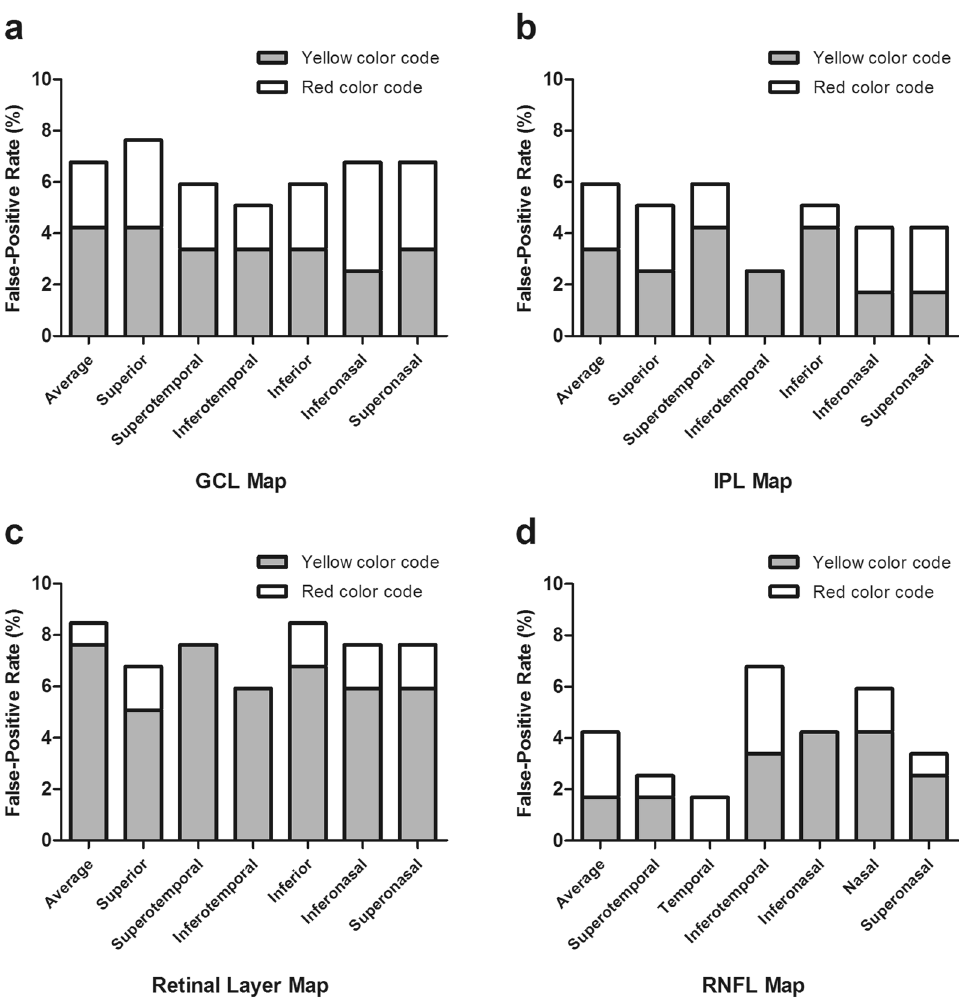
Figure 2. False-positive rates on sector maps of Spectralis OCT. The false-positive rates are represented in yellow (outside the 95% normal limit) and red (outside the 99% normal limit) color codes on the ganglion cell layer (GCL) map ( a ), inner plexiform layer (IPL) map ( b ), retinal layer map ( c ) and retinal nerve fiber layer (RNFL) map ( d